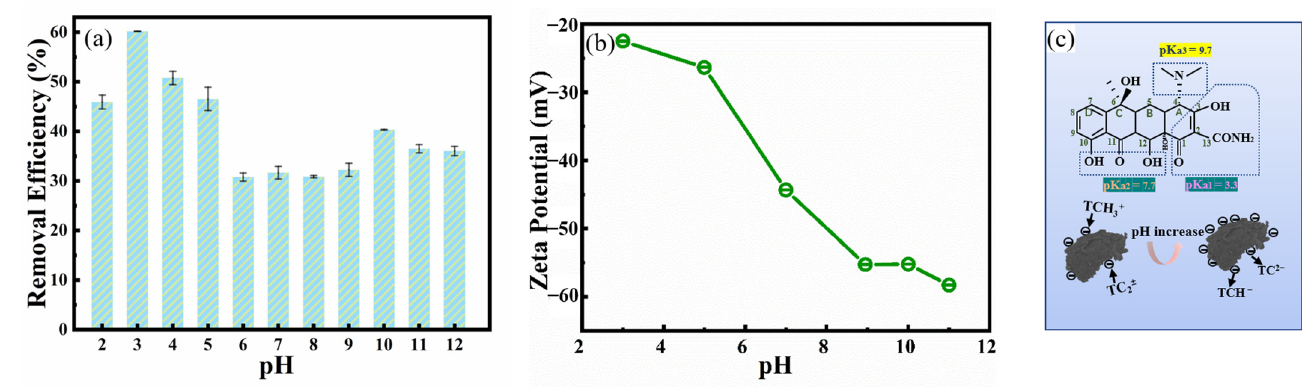
Figure 5. Effect of adsorbent particle size for TC adsorption: ( a ) Effect of CG particle size on removal efficiency and adsorption capacity of TC by CG (contact time of 3 h, TC concentration of 40 mg/L, CG dosage of 1 g/L, pH of 6.2 and temperature of 25 °C, 120 rpm), ( b ) the proposed schematic diagram of TC adsorption by CG with reduced CG particle size.